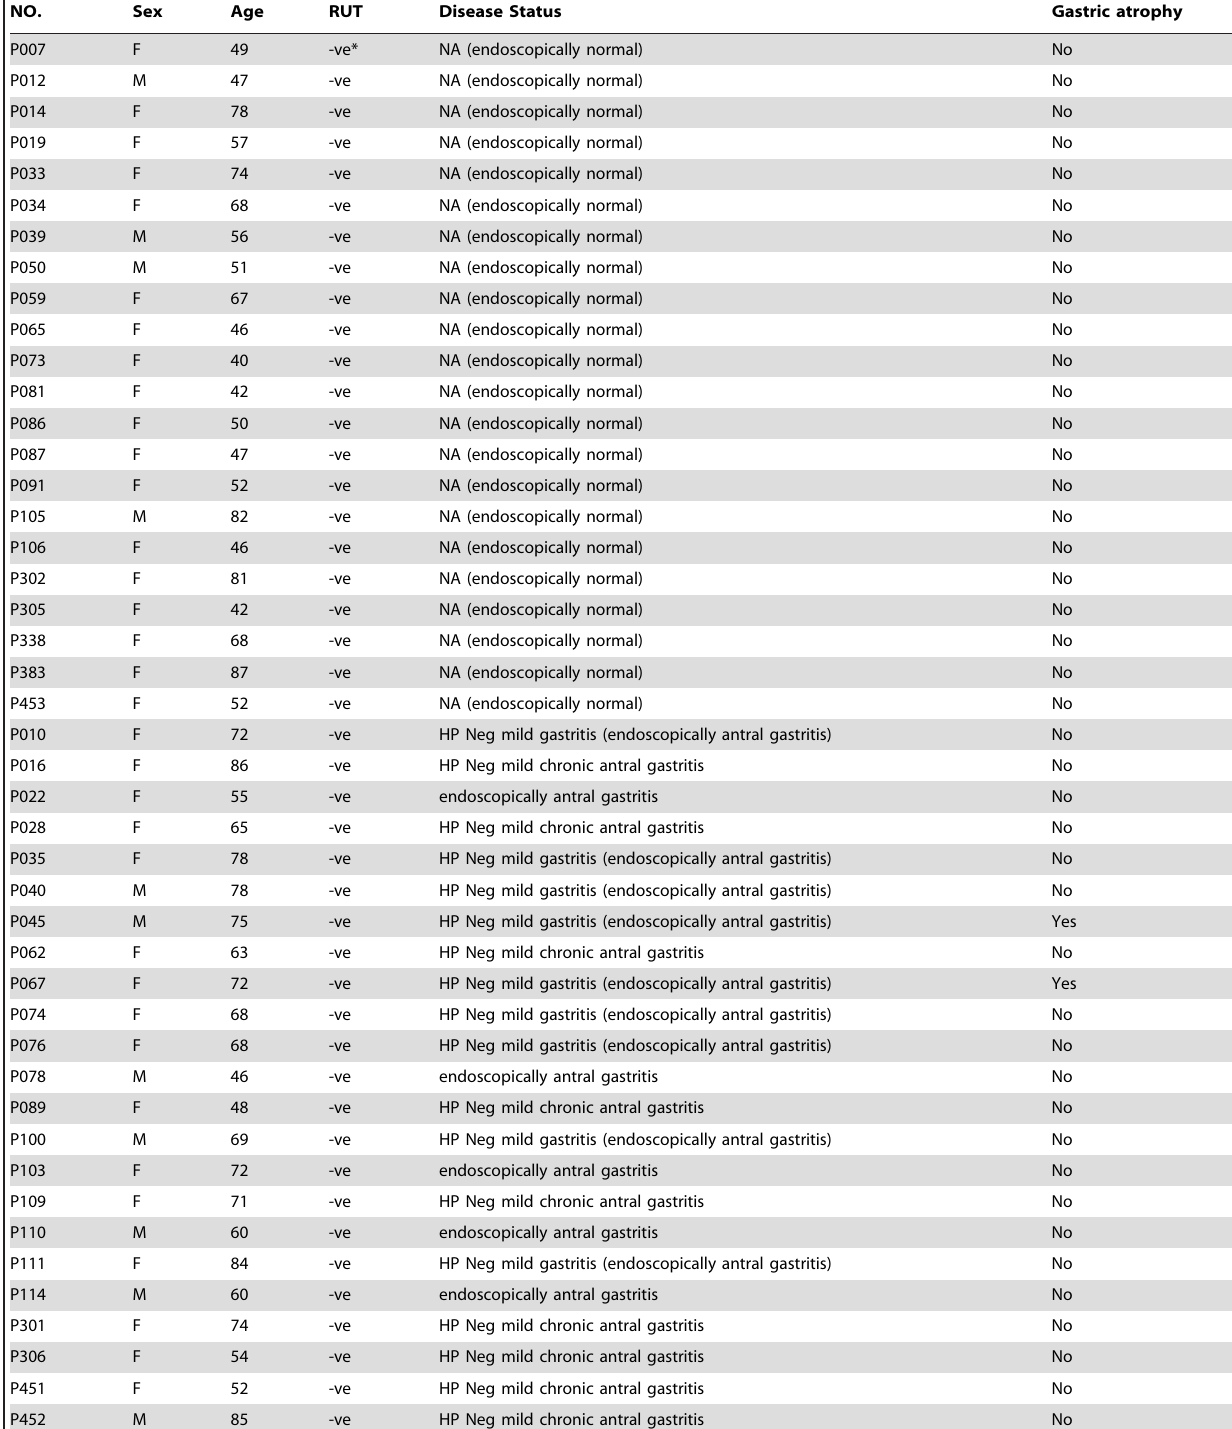
Table 2. Patient